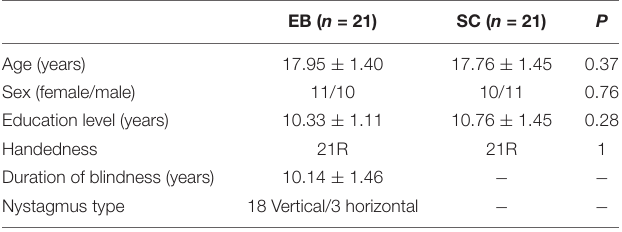
correlation number r ≥ 0.25 were calculated using the